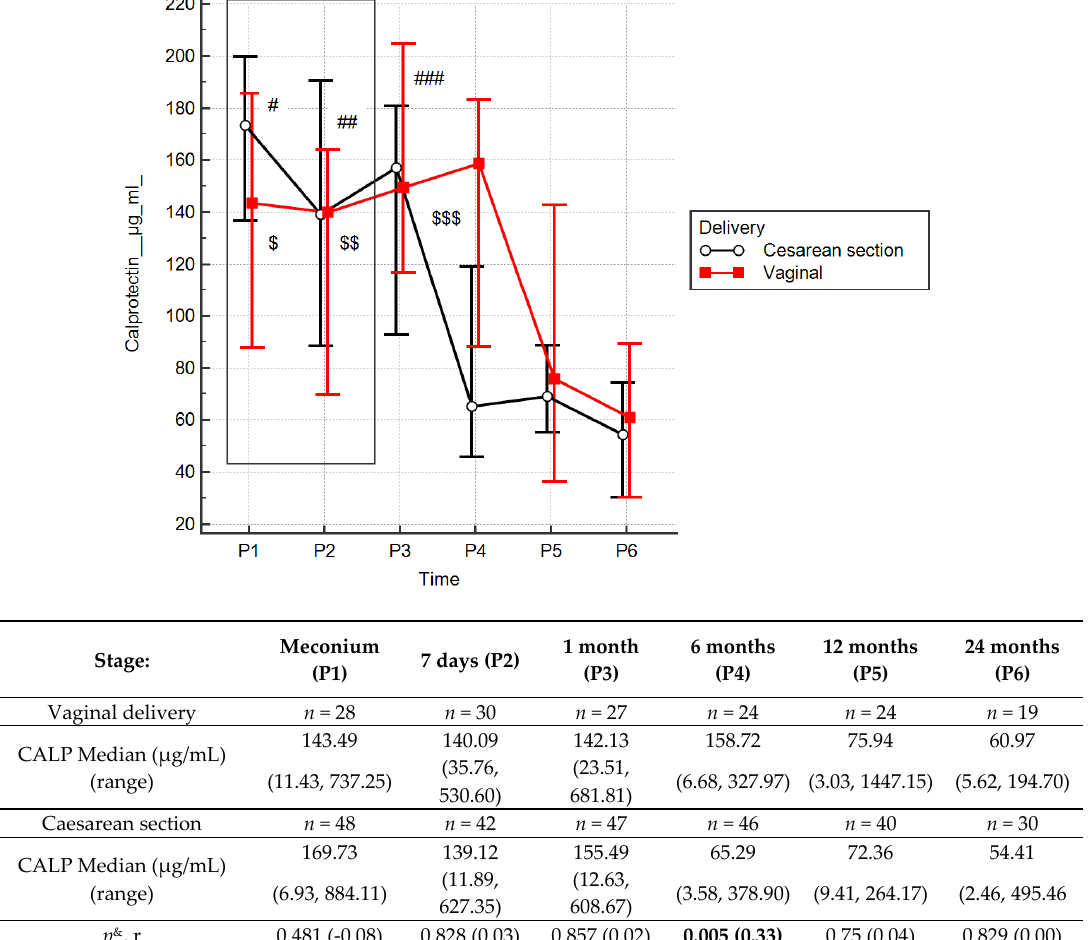
Figure 5. Calprotectin (CALP) concentrations (median) over time with delivery type: caesarean section (black line) or vaginal birth (red line). Legend: Error bars represent 95% confidence intervals for medians. p & = Mann-Whitney test comparing effects of delivery type, r = effect size. Wilcoxon paired tests comparing times, # (Caesarean section), $ (Vaginal delivery): #, $ p < 0.05 P1 vs. P4, P5 and P6;